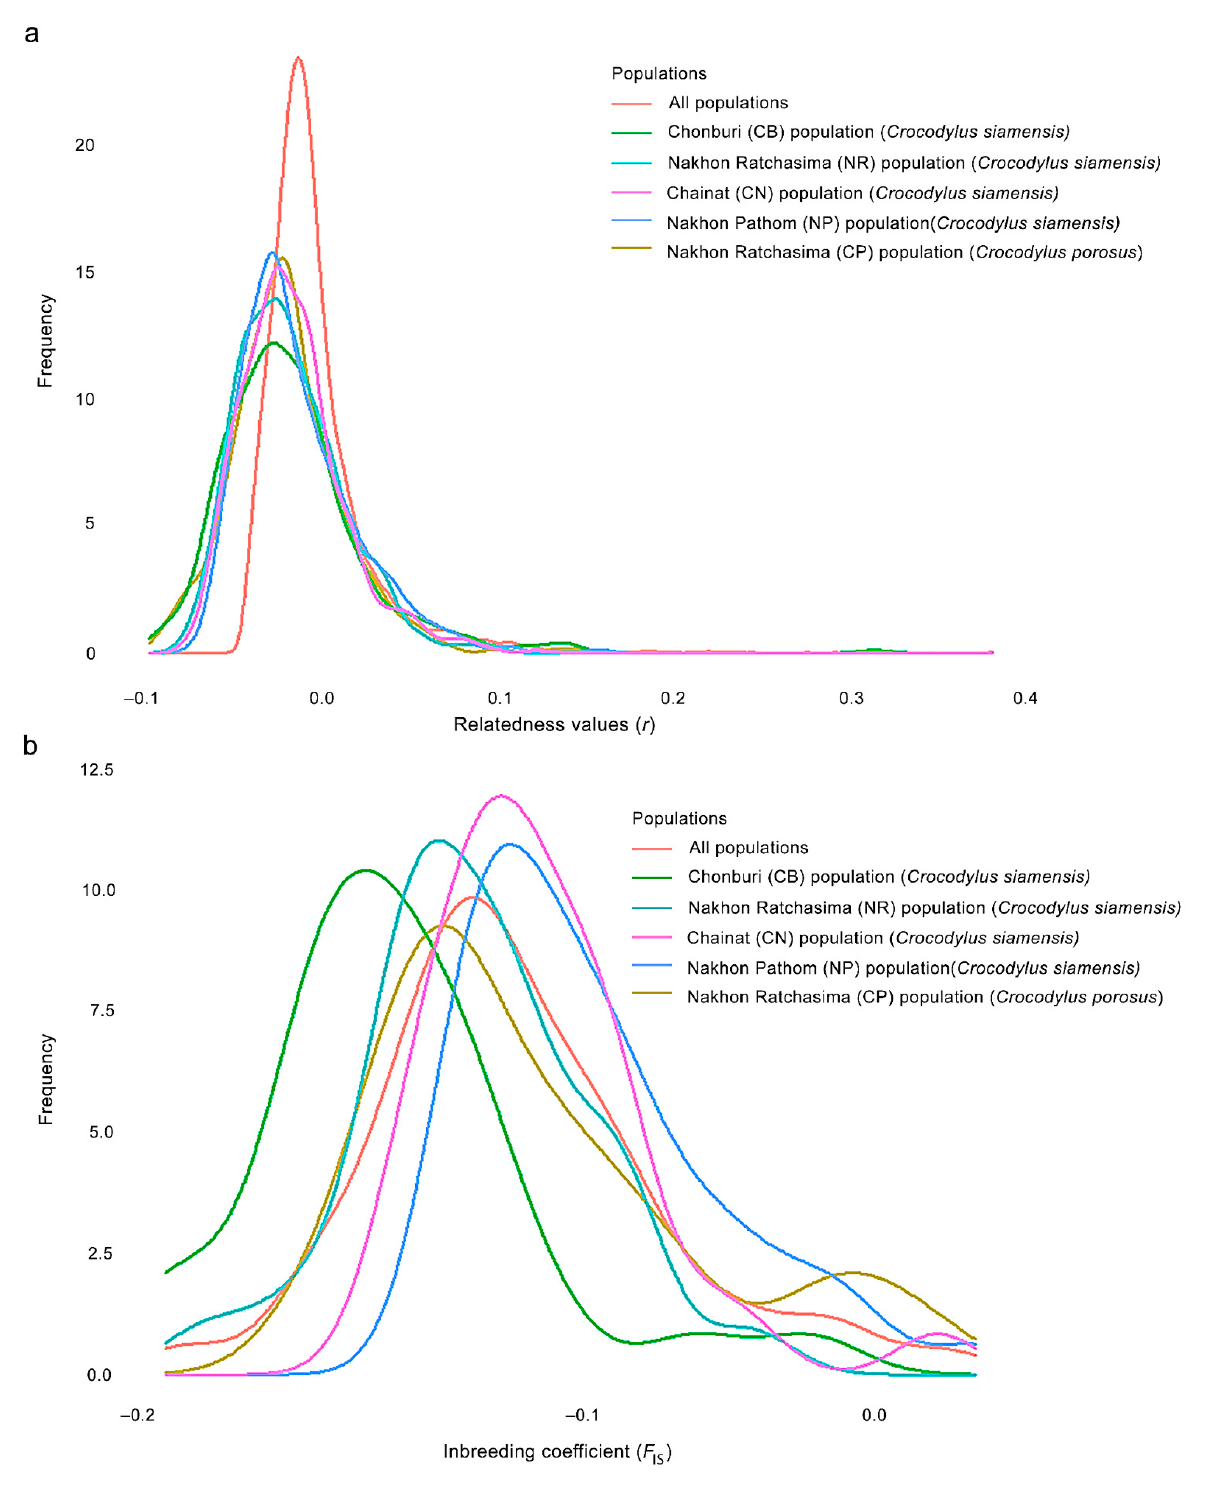
Figure 1. Observed distribution of ( a ) pairwise relatedness ( r ) and ( b ) inbreeding coefficients ( F IS ) for 136 Siamese ( Crocodylus siamensis , Schneider, 1801) [1] and 29 saltwater crocodiles ( C. porosus , Schneider, 1801) [13] individuals, plo tt ed against the expected distributions.